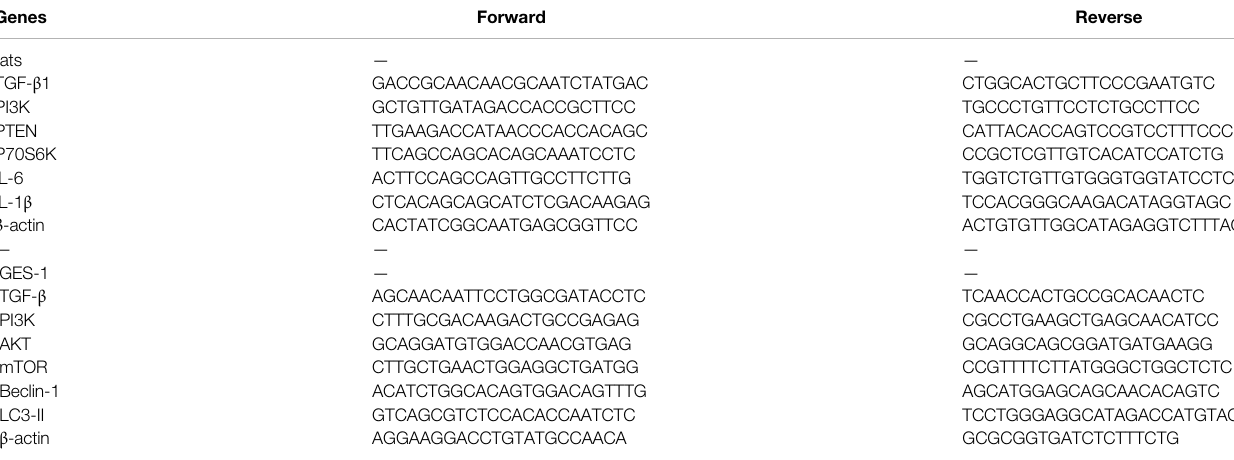
TABLE 1 | Primers sequences of real-time PCR analyses for mRNA expression. Genes Forward